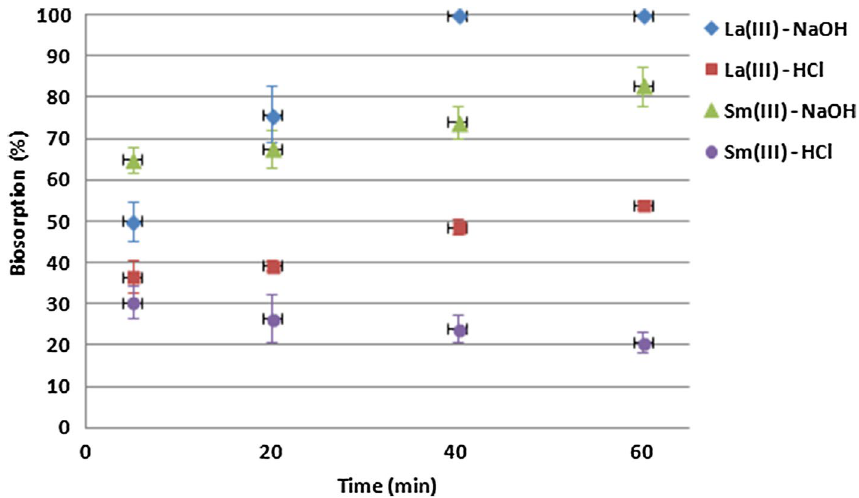
Fig. 3 Effect of contact time on the biosorption of La 3+ and Sm 3+ by pre-treated Bacillus subtilis cells in single